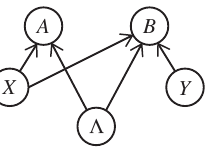
FIG. 3. Example of a causal structure that can reproduce violations of KS inequalities with